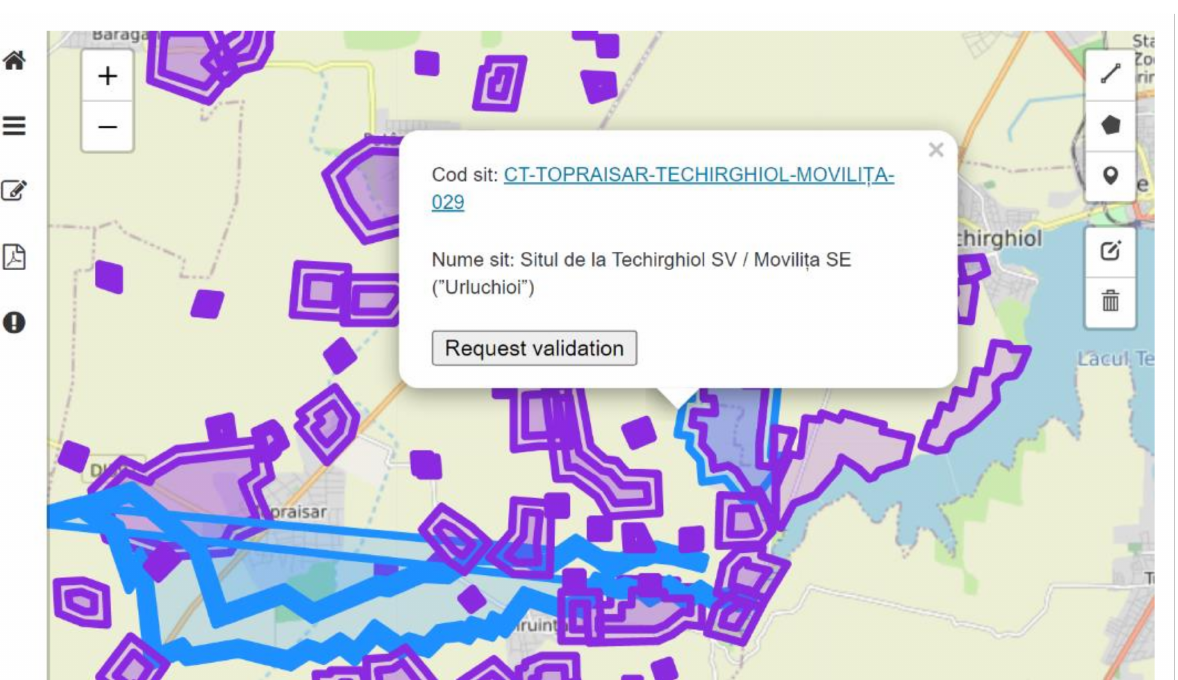
Figure 14. WGS84 and Stereo70 coordinates converted for each archeological site area corner.